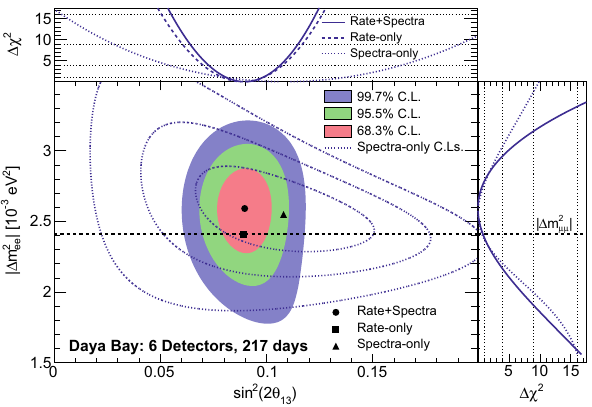
Figure 1. (Color online) Allowed regions for the neutrino oscillation parameters sin 2 2 θ 13 and | Δ m 2 ee | at the 68.3, 95.5 and 99.7% confidence levels, obtained from comparison of the rates and prompt energy spectra measured by the 3 near-site and 3 far-site antineutrino detectors (solid regions). The best estimate of the oscillation parameters is given by the black dot. The three dotted contours indicate the allowed 68.3, 95.5 and 99.7% C.L. regions for the spectra-only fit with the black triangle representing best estimate of the oscillation parameters. The adjoining panels show the dependence of Δ χ 2 on | Δ m 2 ee | (right) and sin 2 2 θ 13 (top). The black square and dashed curve represent the rate-only result. The dotted curves represent the spectra-only Δ χ 2 distributions. The dashed horizontal line represents the MINOS | Δ m 2 μμ |